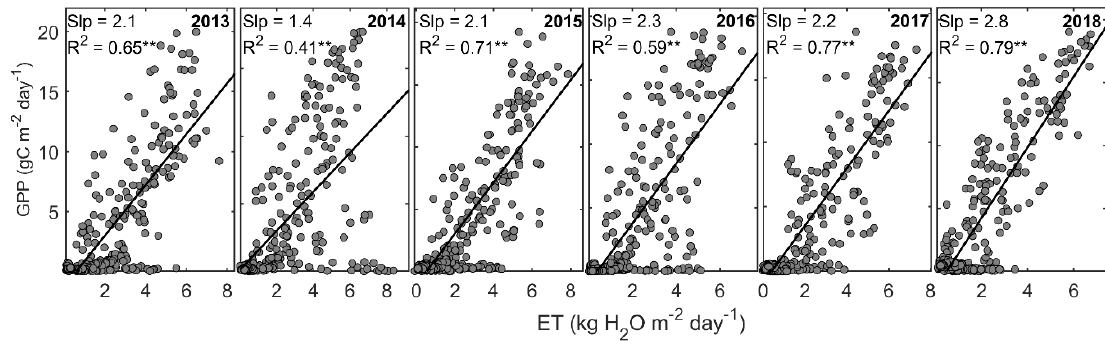
Figure 8. Relationship between daily gross primary production (GPP) and evapotranspiration (ET) during the periods of 2013 – 2018. The symbol ** indicates the statistical significance level of 0.01.